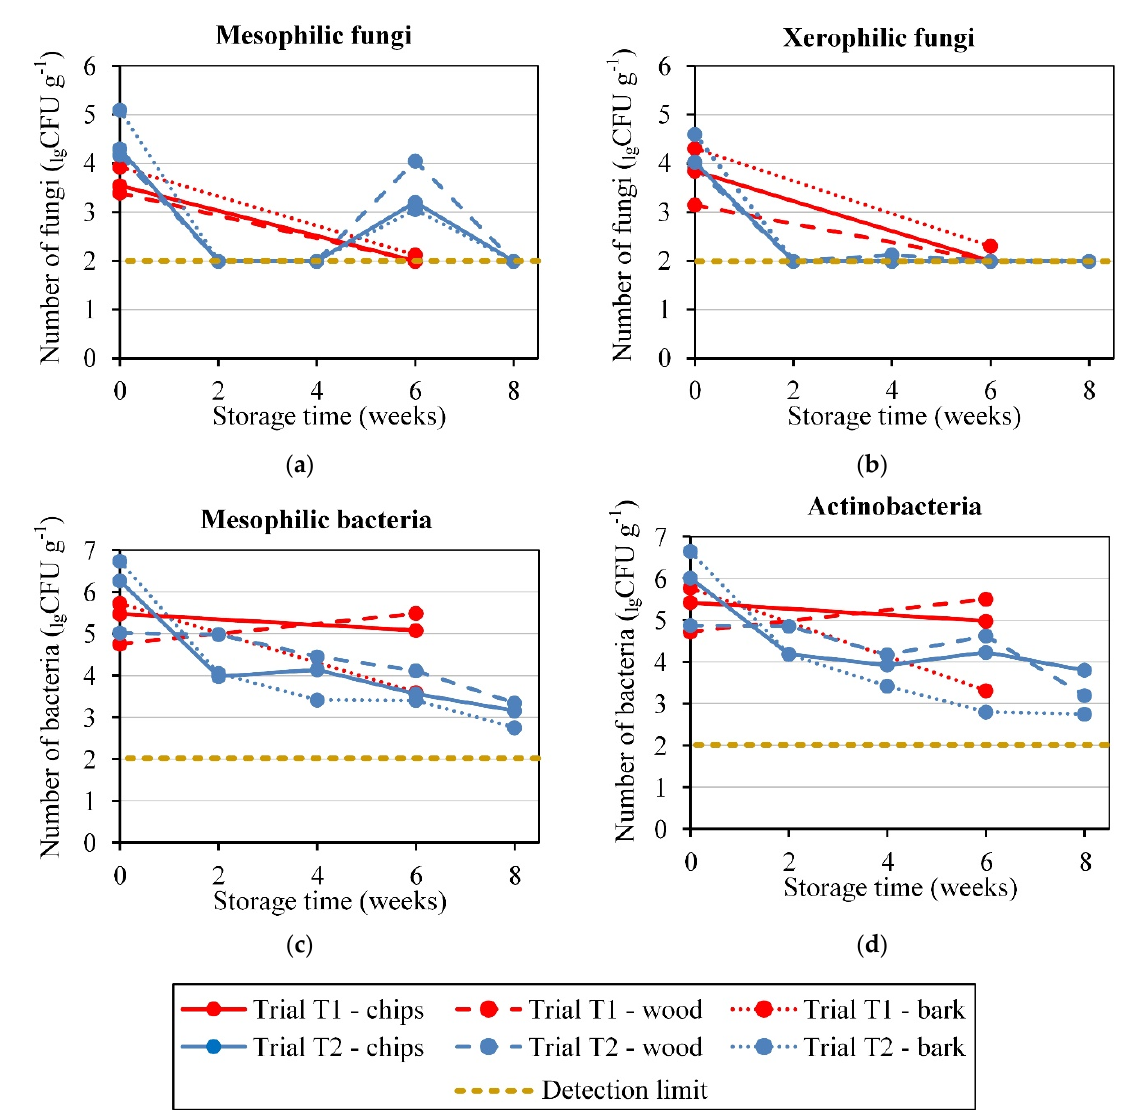
Figure 5. Results of the microbiological analyses of poplar chips, wood and bark of trials T1 and T2.